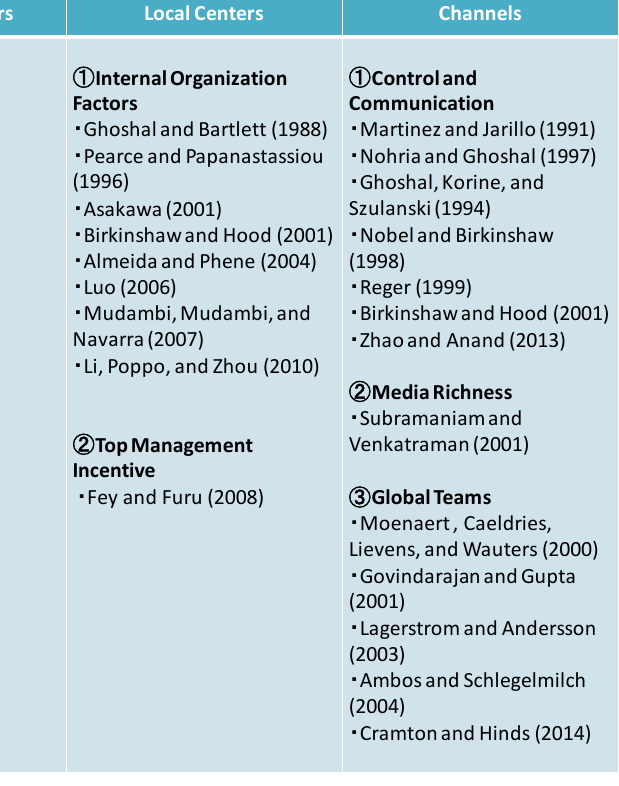
Table 1. Classification of preceding